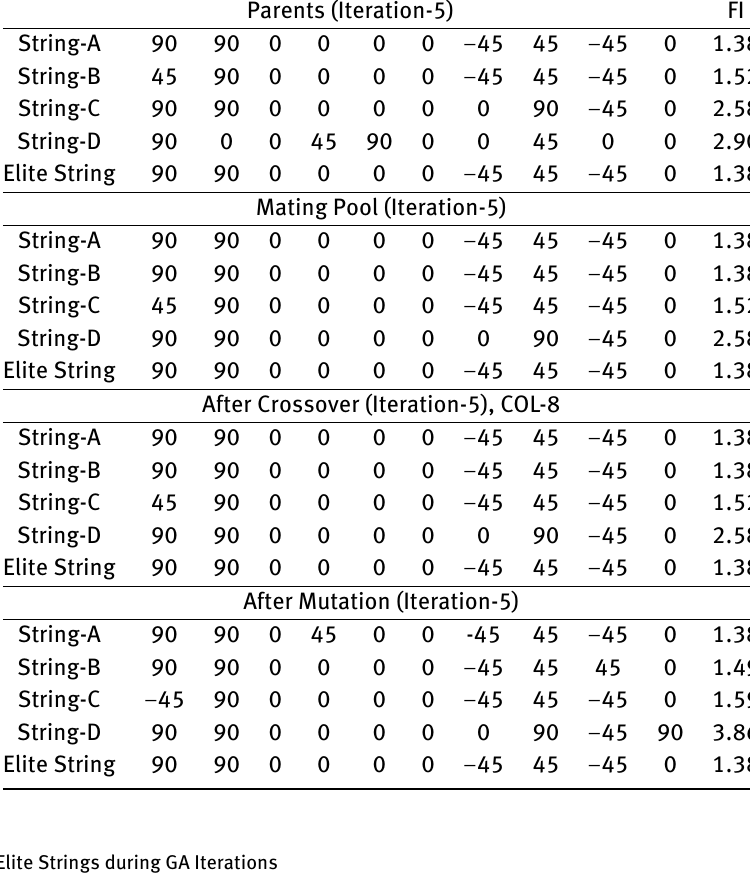
Table 9: Development of Elite Strings during GA